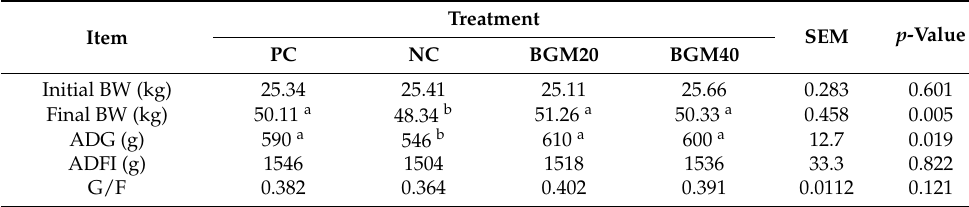
Table 2. Effect of dietary BGM with combined enzymes inclusion on growth performance of growing pigs 1 .